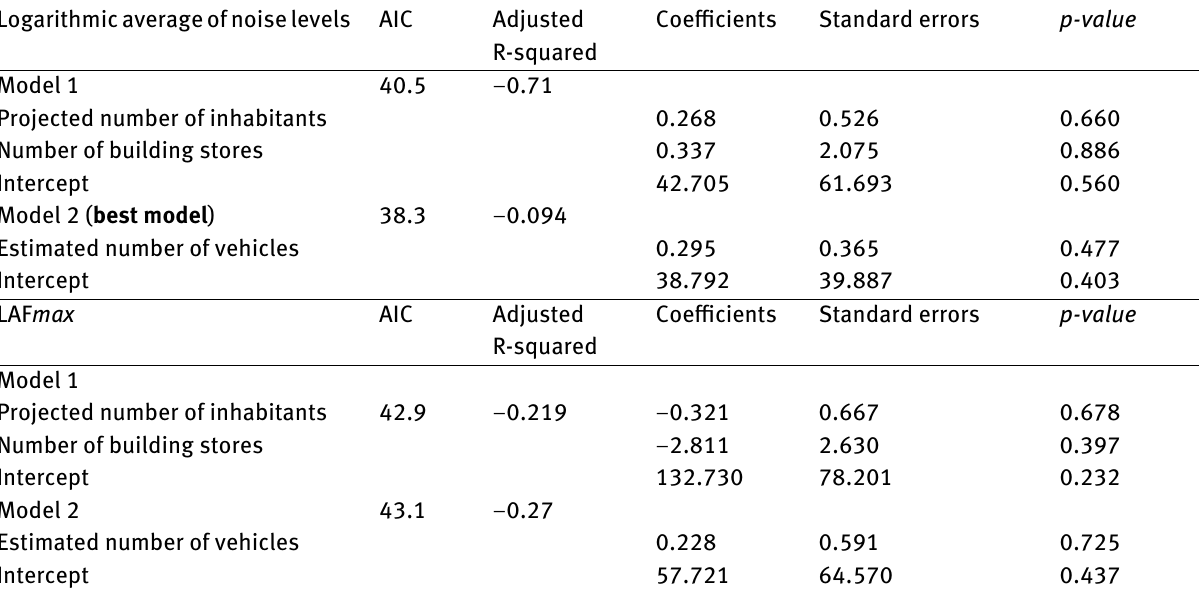
Table 3: Summary of OLS coeflcients, standard errors and p-values for the logarithmic average value of noise level of LAeq, and maximal noise levels, LAF max